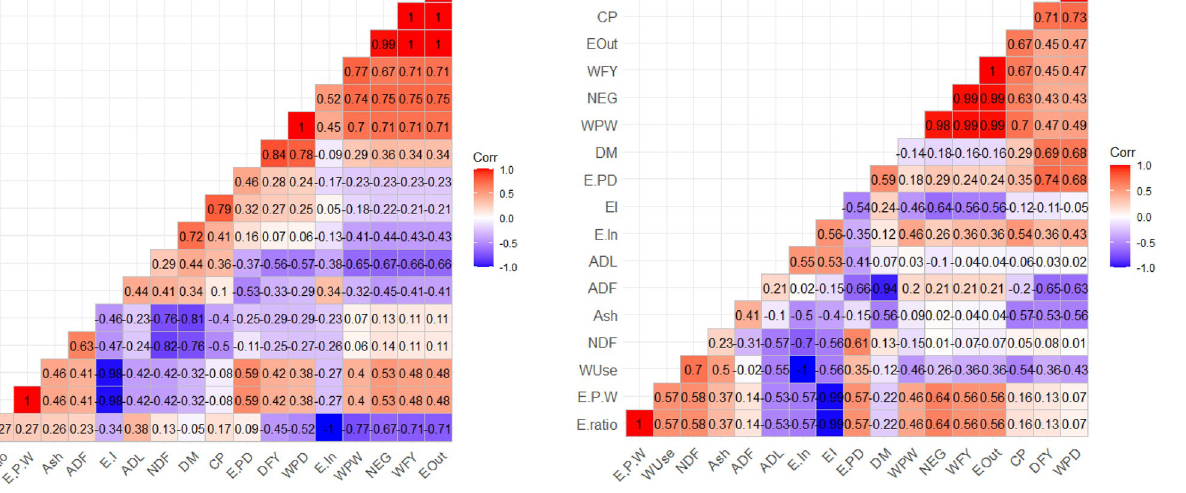
Fig. 3 Correlation plot for measuring association between meas- ured traits of maize under full irrigation (100%). W Use: water use, E.ratio: energy ratio, E.P.W: energy productivity of wet forage yield, ADF: cell wall hemicellulose free, E.I: energy intensity, ADL: lignin, NDF: neutral detergent fiber, DM: dry matter, CP: crude protein, E.P.D: energy productivity of dried fodder yield, DFY: dried fodder yield, WPD: wet forage yield, E.In: input energy, WP.W: water pro- ductivity of wet forage, N.E.G: net energy gain, WFY: wet forage yield, E.Out: output energy